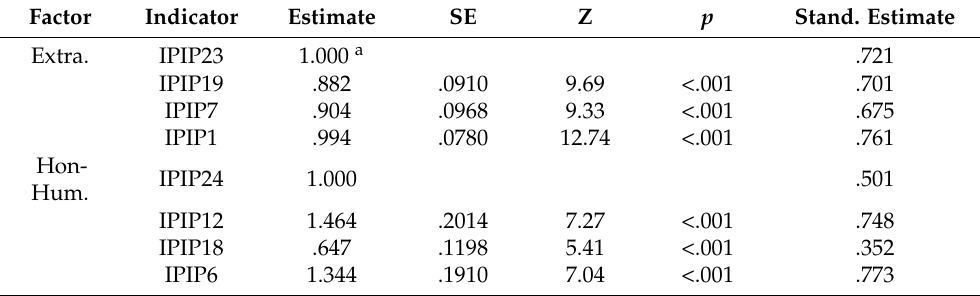
Table A2. Factor loadings of CFA (Mturk sample). Factor Indicator Estimate SE Z p Stand. Estimate Agree. IPIP2 1.000 a IPIP8 IPIP14 Consc. IPIP10 1.000 a IPIP22 IPIP11 Neuro. IPIP17 IPIP15 Open. IPIP21